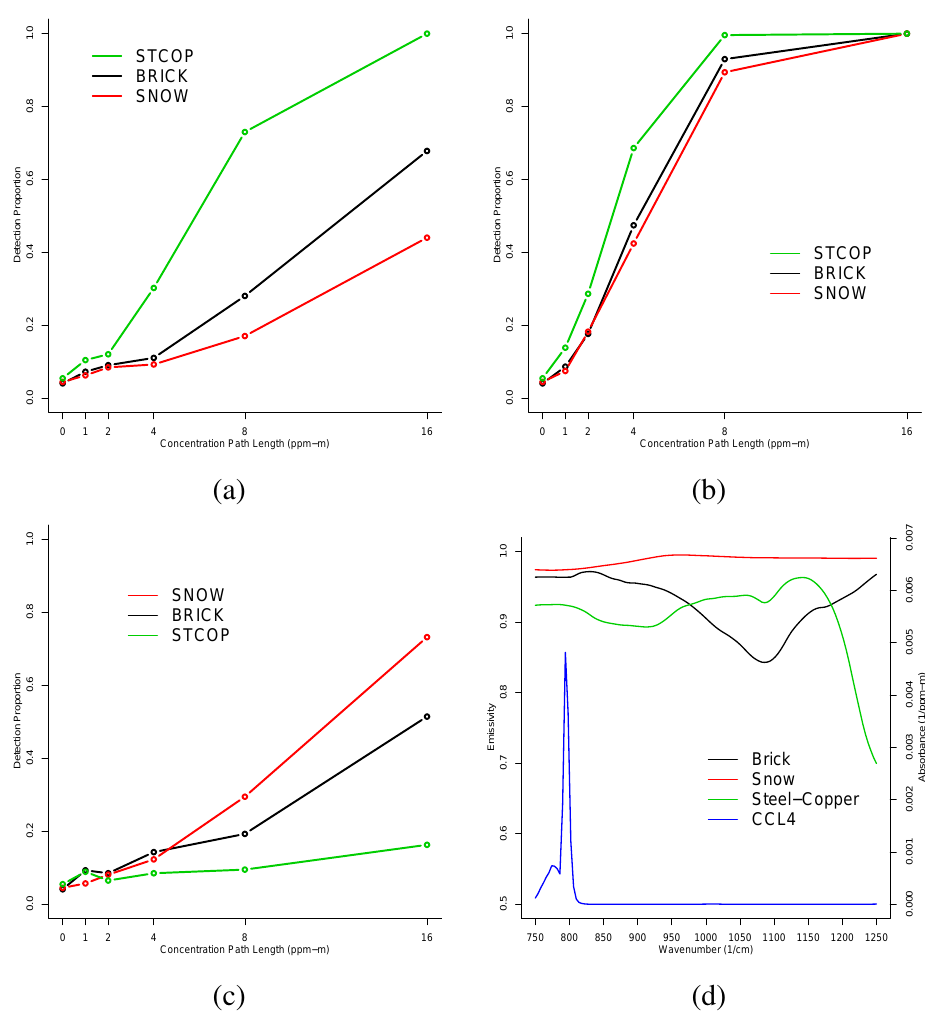
Figure 3. Detection proportions for CCL T = 300 K , (c) T g